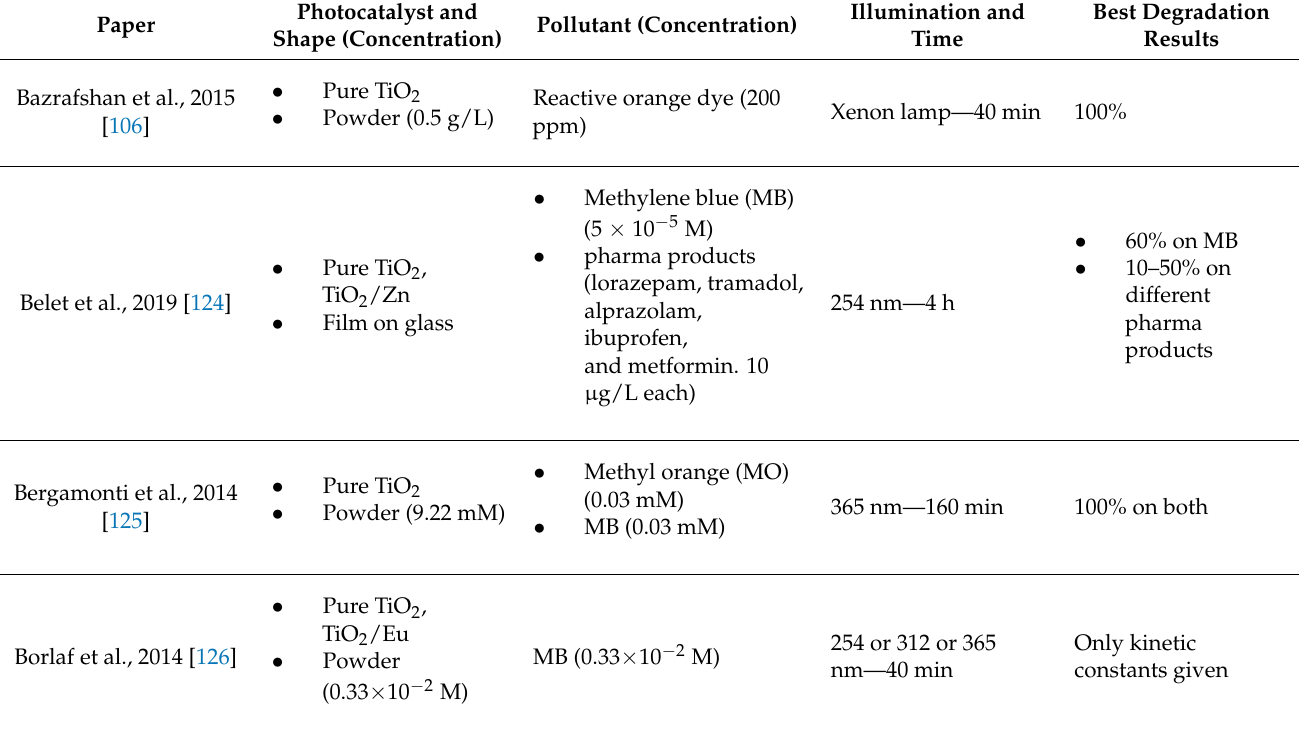
Table 2. Parameters of photocatalytic experiments in studies using as-synthesized TiO 2 materials.